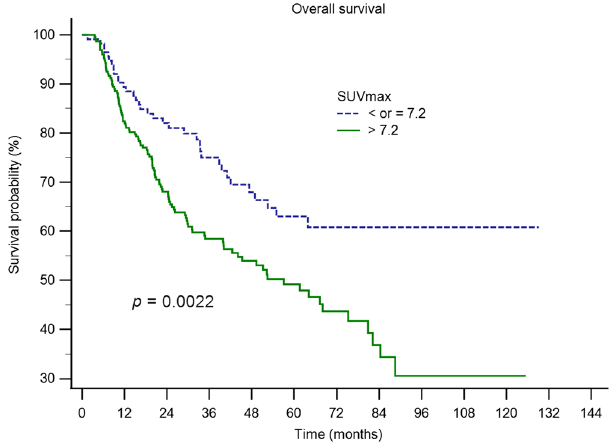
Figure 4. Kaplan–Meier curves for OS of patients disaggregated into two groups using the tSUVmax cutoff value of 7.2. Results show significant difference in OS between the two groups (p =